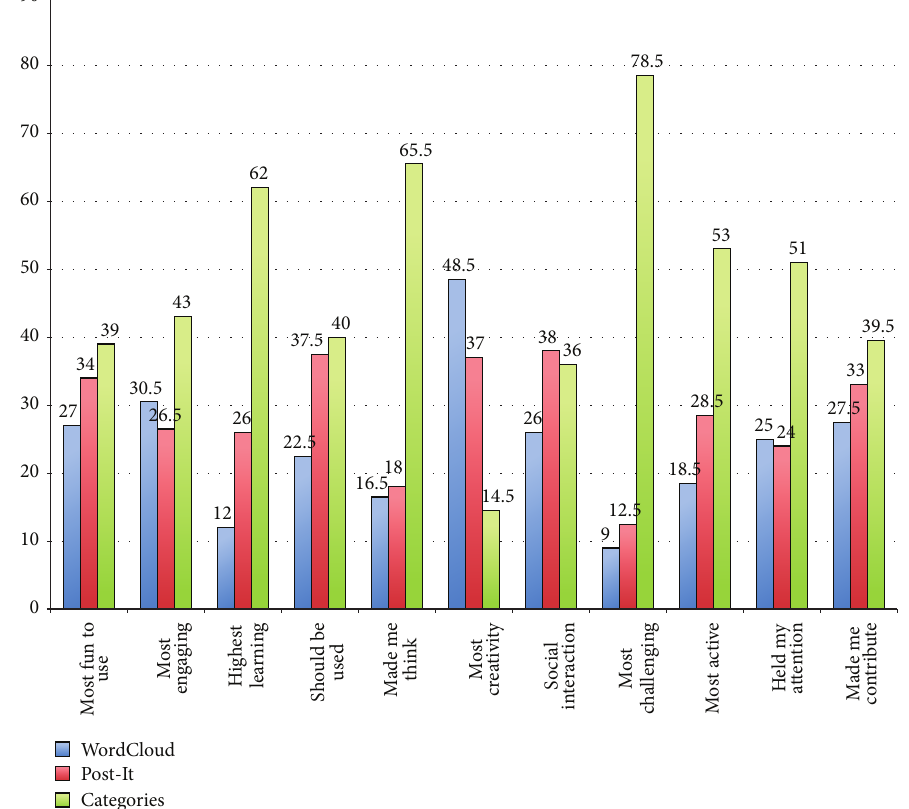
Figure 12: Results of the evaluation of use of applications from lectures one and